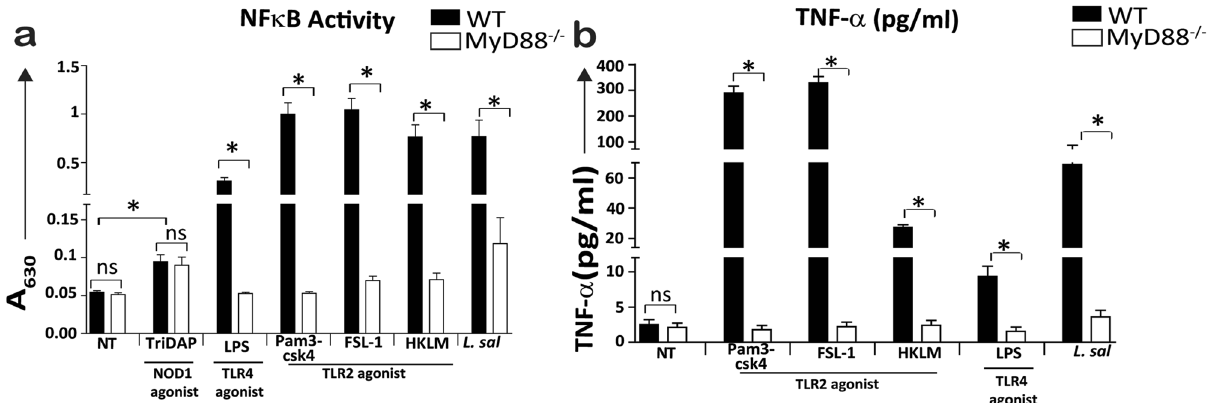
Figure 2. L. salivarius UCC118 stimulated NF-κB activity and cytokine responses were MyD88 dependent in THP-1 monocytes. ( a ) NF-κB transcriptional activity and ( b ) TNF-α cytokine secretion was measured in